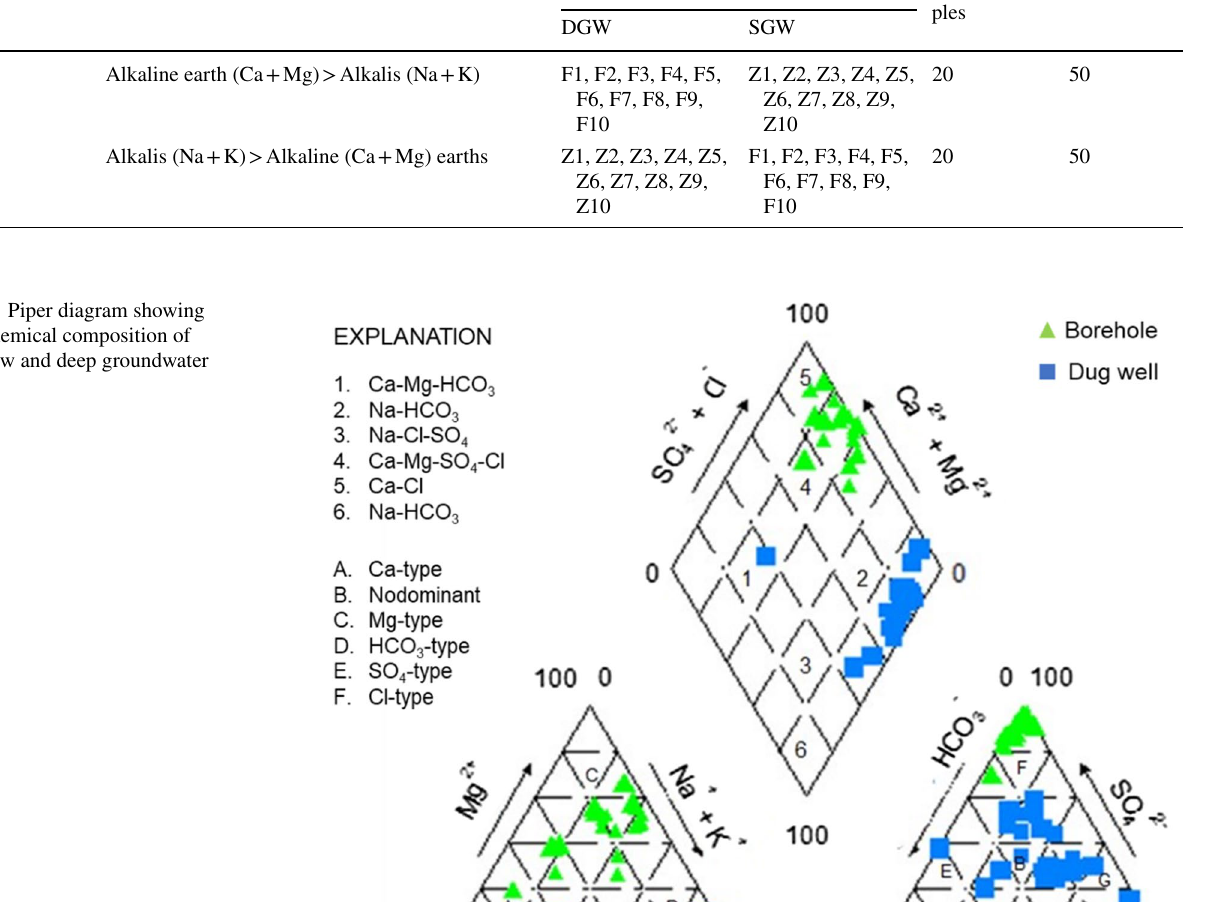
Table 10 Geochemical characterization of groundwater samples Geochemical facies